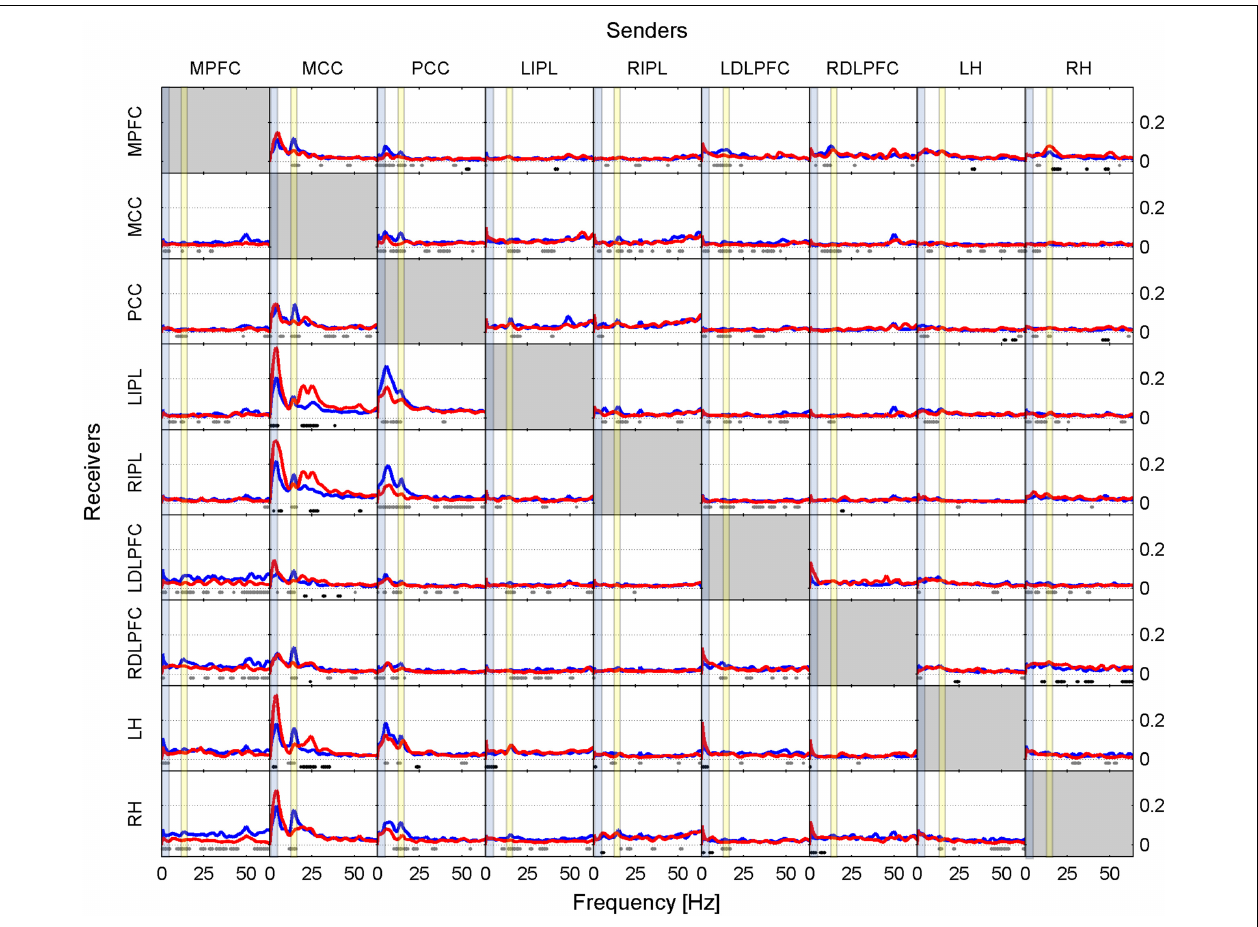
FIGURE 1 | Effective connectivity assessed by iCOH at the SOn transition in baseline. iCOH values representing connectivity strength (effect size) as a function of frequency for any pair of ROIs. Plots arranged as a square matrix of order 9; columns represent “senders”, rows are “receivers” of information flow. For the abbreviations of the ROIs see Table 1 . iCOH spectra before SOn (red curves) and after SOn (blue curves) are depicted and the frequency range is from 0.5 to 64 Hz (0.5-Hz resolution). Dots below the curves indicate significant differences between iCOH after SOn vs. iCOH before SOn: gray dots iCOH after SOn > iCOH before SOn; black dots iCOH after SOn < iCOH before SOn. To facilitate orientation, the delta (0.5–5 Hz) and sigma (12–16 Hz) band have been highlighted by light blue and light yellow,